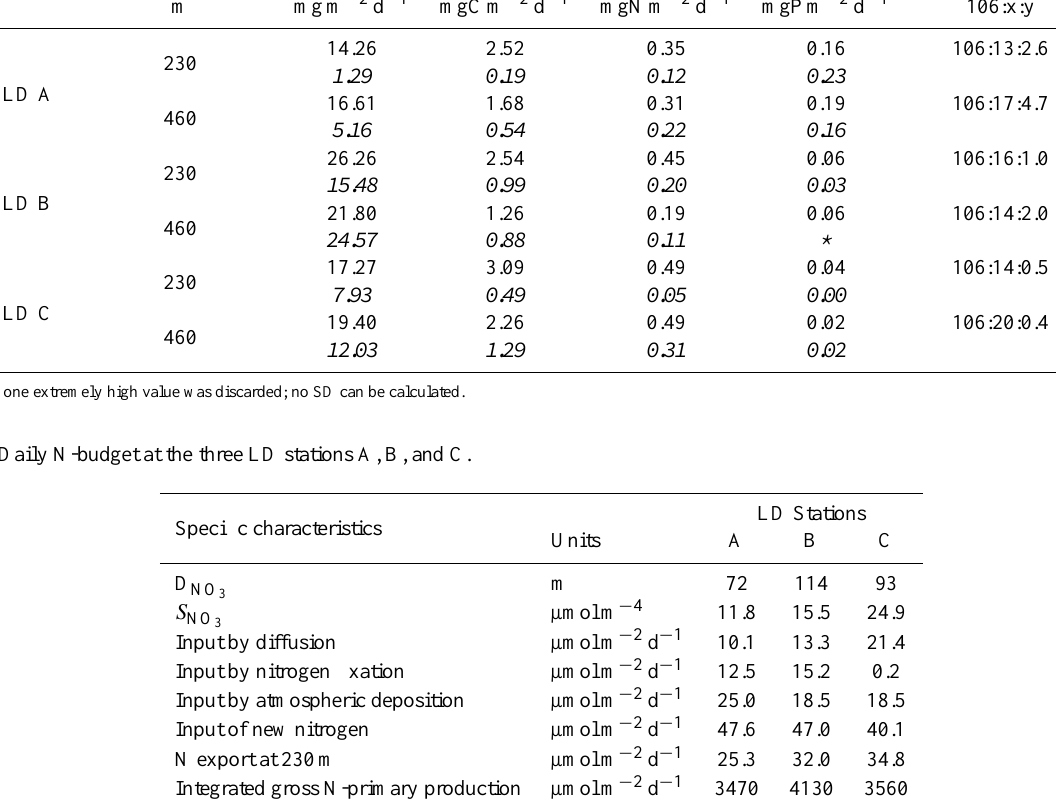
Table 3. Sediment trap data at the LD stations. Depth of collection, mean mass flux inmgm − 2 d − 1 of matter (DW) and for each elements C, N and P (sd in italics), mean C:N:P molar ratio. Station